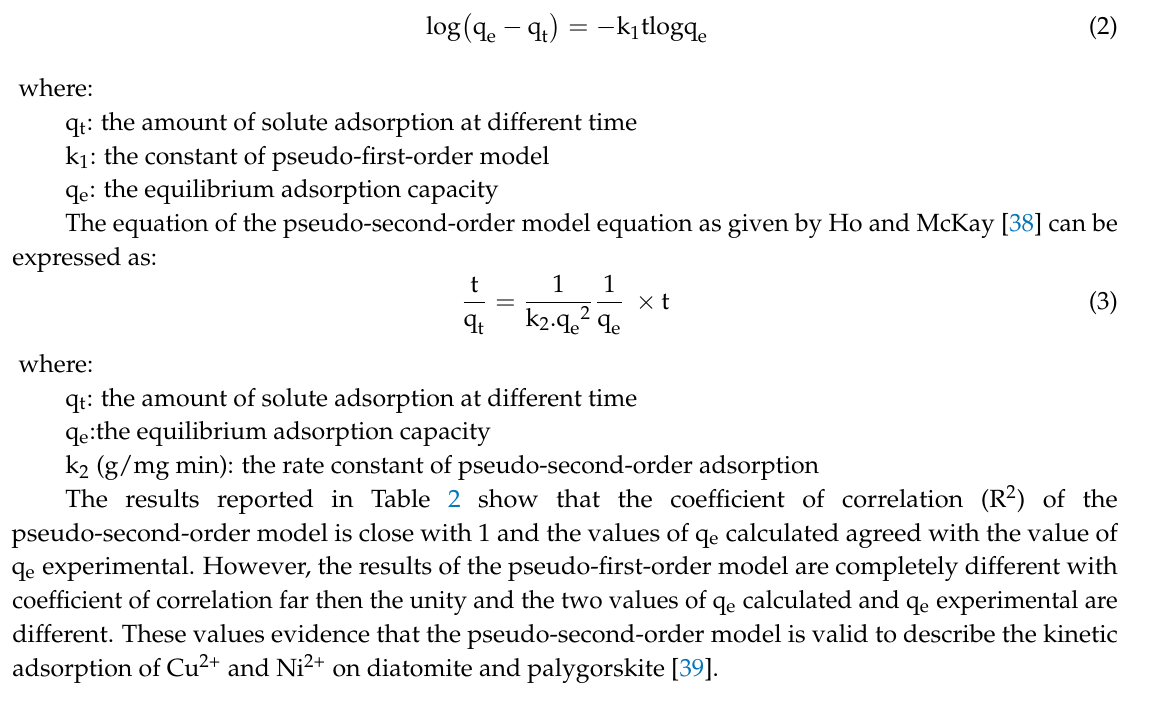
Table 2. Parameters for kinetics models for Cu 2+ and Ni 2+ adsorption onto treated diatomite. Ni 2+ Cu